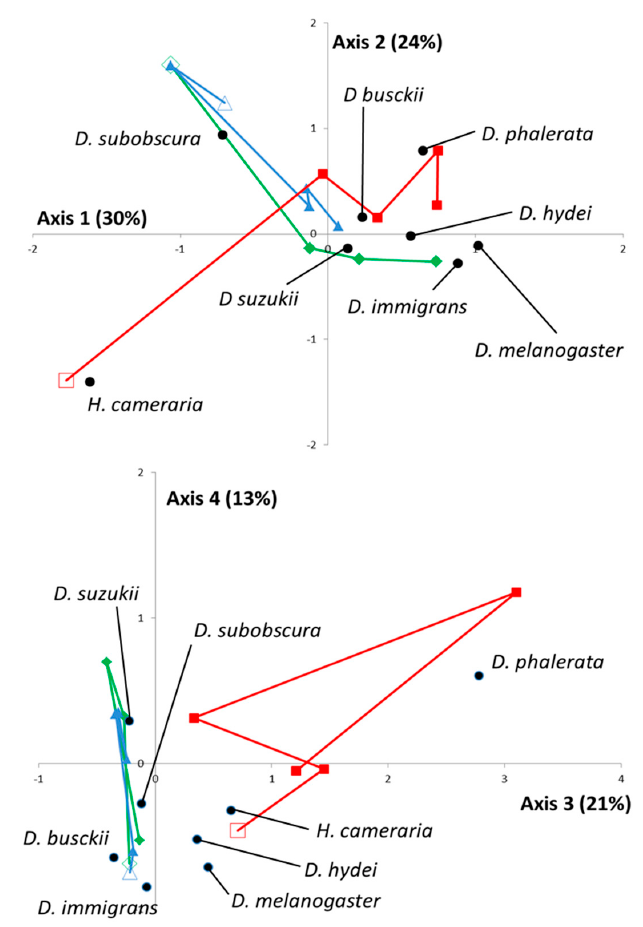
Figure 1. Factorial correspondence analysis (FCA) on wild adults collected with the “Vinegar-Wine” method. The FCA analysis was performed on the table of contingency obtained from the distribution of each of the drosophilid species in each “location x date” combination. The projected inertia is provided for each axis. The “location x date” combination is visualized as follows. For the “locations”, green diamonds, red squares, and blue triangles represent BAR (low elevation—cultivated area), TIG (low elevation—natural habitat), and CIP (mountainous backlands), respectively (see also Table 1). For the “dates”, empty figures indicate the starting date (February 2015). The projection of each drosophilid species is explicitly indicated by a black point.